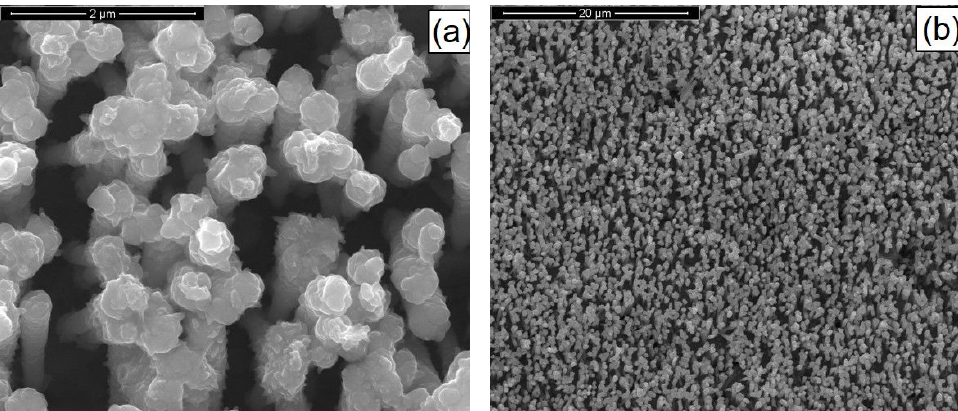
Figure 6. SEM images of CZTSe NWs sample after CZTSe film deposition. High ( a ) and low ( b ) magnification. NWs were obtained at pH = 3 with a copper content of 1 mM.